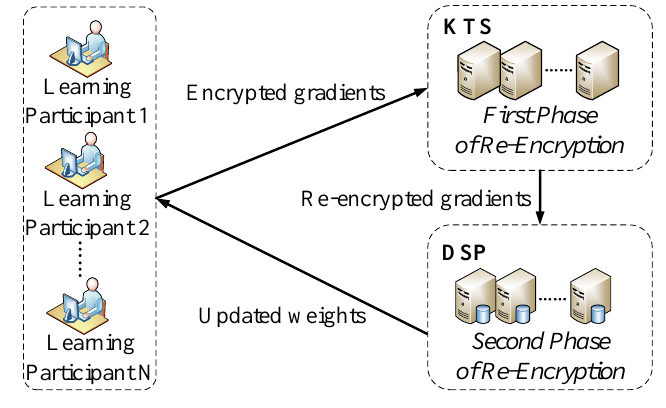
Figure 2. System